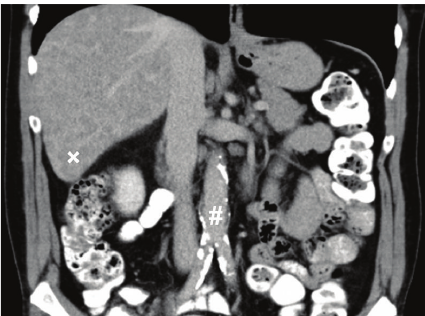
Figure 1: Abdominal CT-scan showing diffuse calcifications of the infrarenal aorta and aortic bifurcation (#) as well as mild ectasia (3cm). Note the diffuse hepatic metastatic disease (x).